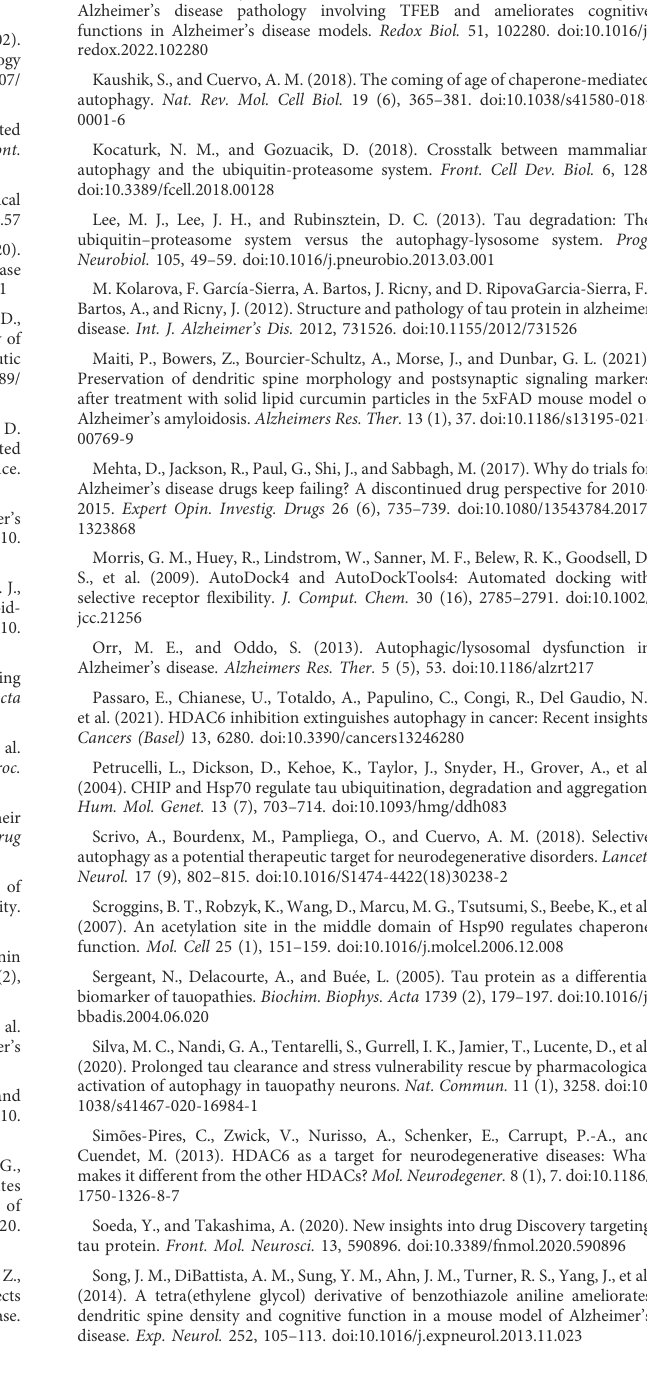
enhances LAMP2A expression dose-dependently. LAMP2A (green) and DAPI (blue). (C,D) Immunoblotting results show that PRO-Br mediated the increase in LAMP2A and HSC70 expression in a dose- dependent manner. Data are represented as mean ± SEM of 3 replicates. Data were quanti fi ed using Image J software, * p < 0.05 and ** p <